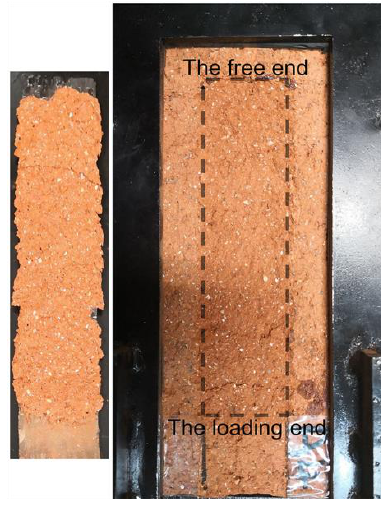
Figure 4. The peeling of CFRP and a thin layer of brick.